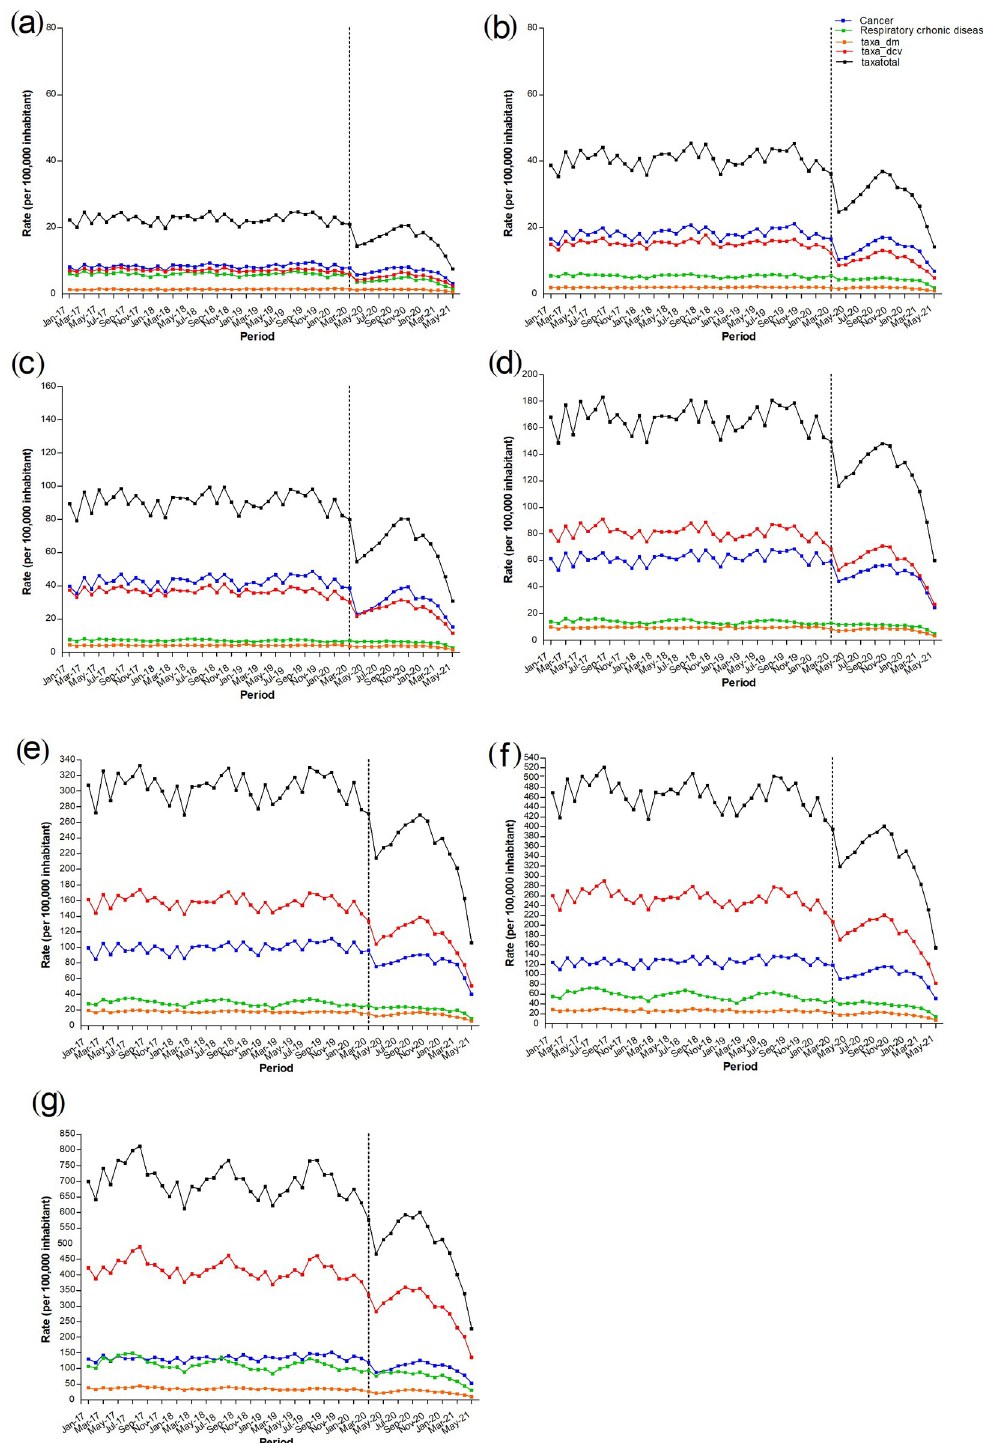
Fig 3. Hospital admission rate for chronic non-communicable diseases (NCDs) in Brazil according to the type of NCD and age group: (a) 20–29 years, (b) 30–39 years, (c) 40–49 years, (d) 50–59 years, (e) 60–69 years and (f) 70–79 years and (g) � 80 years. Pre-pandemic period: January 1, 2017 to February 29, 2020; Pandemic period: March 1, 2020 to May 31, 2021.